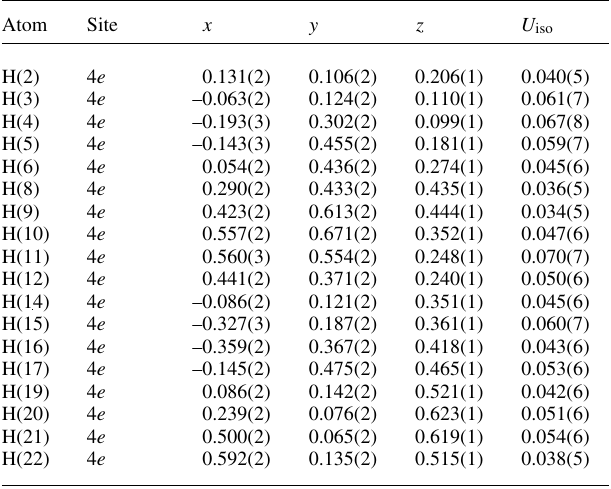
Table 2. Atomic coordinates and displacement parameters (in Å 2 )